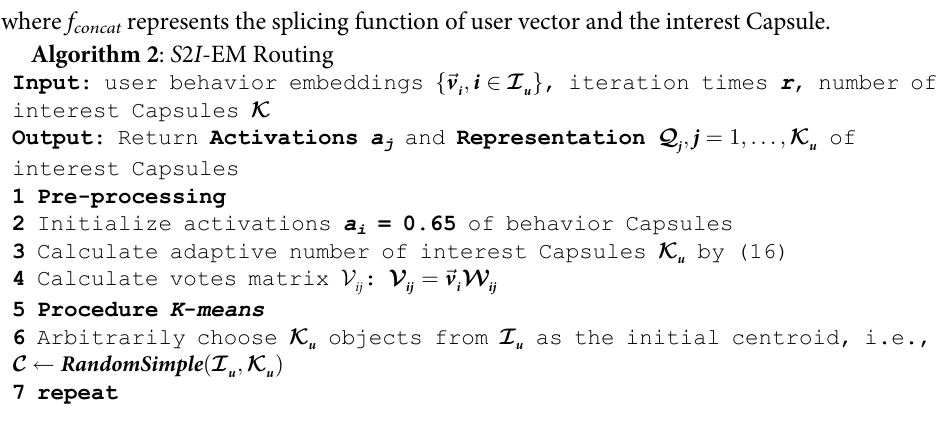
Algorithm 2 : S 2 I -EM